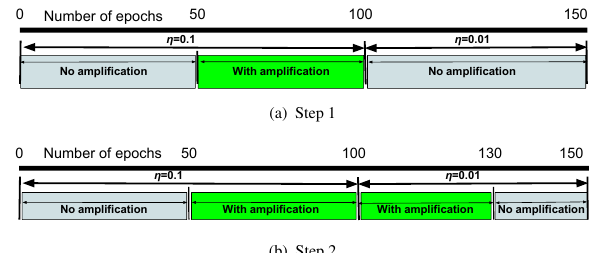
Fig. 2 Two-step training process carried out during performance analysis of deep learning models.